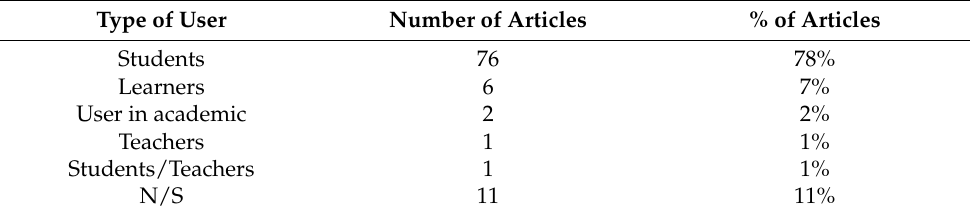
Table 6. Percentage number of articles according to type of user.